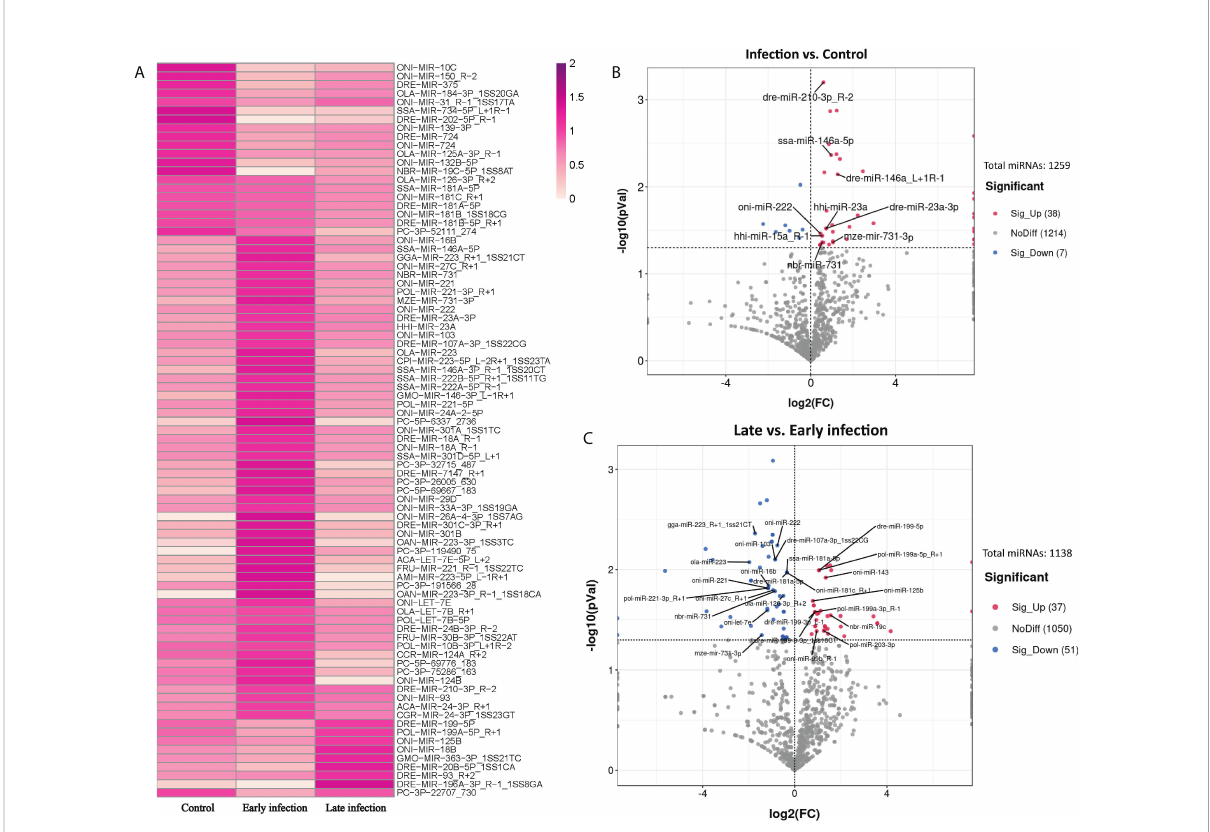
FIGURE 3 Exosomal miRNAs in the plasma with distinguished levels in control, early and late infection groups. (A) Heatmap showing the levels of 85 exosomal miRNAs with signi fi cant differences in control, early and late infection groups ( P < 0.05) (Dark red: higher level; Light red: lower level). (B) Volcano plot showing the levels of 45 exosomal miRNAs with signi fi cant differences between control and infection groups ( P < 0.05). (Red points: higher level in infection group; Blue points: lower level in infection group; Grey points: no signi fi cant differences between control and infection groups; Points with labels: high expressed miRNAs). (C) Volcano plot showing the levels of 88 exosomal miRNAs with signi fi cant differences between early and late infection groups ( P < 0.05). (Red points: higher level in late infection group; Blue points: lower level in late infection group; Grey points: no signi fi cant differences between early and late infection groups; Points with labels: high expressed